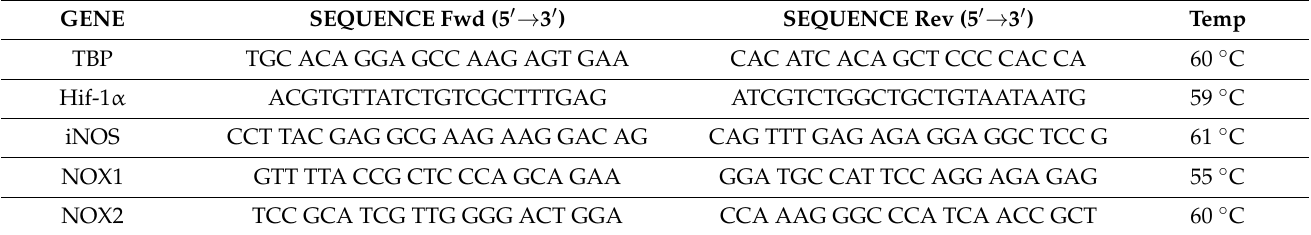
Table 2. Primer sequences used in RT-qPCR and temperature